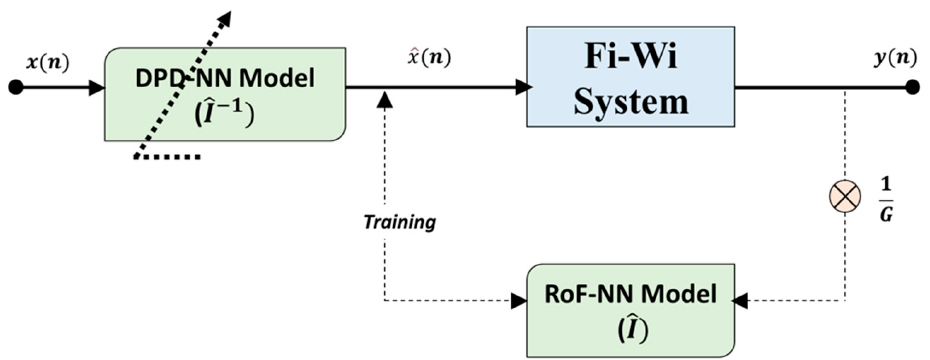
Figure 2. Block schematic of the RoF system, which includes a DPD system based on CNN. The RoF NN model ˆ I is produced by transmitting I/P and O/P through a RoF connection. Then, to train I , we backpropagate error through I − 1 . By cascading the DPD-RoF model to an RoF connection, the model is linearized. DPD is performed in the digital baseband, hence no DACs or ADCs are required. Algorithm 1 displays the relationship between how CNN is created and taught.